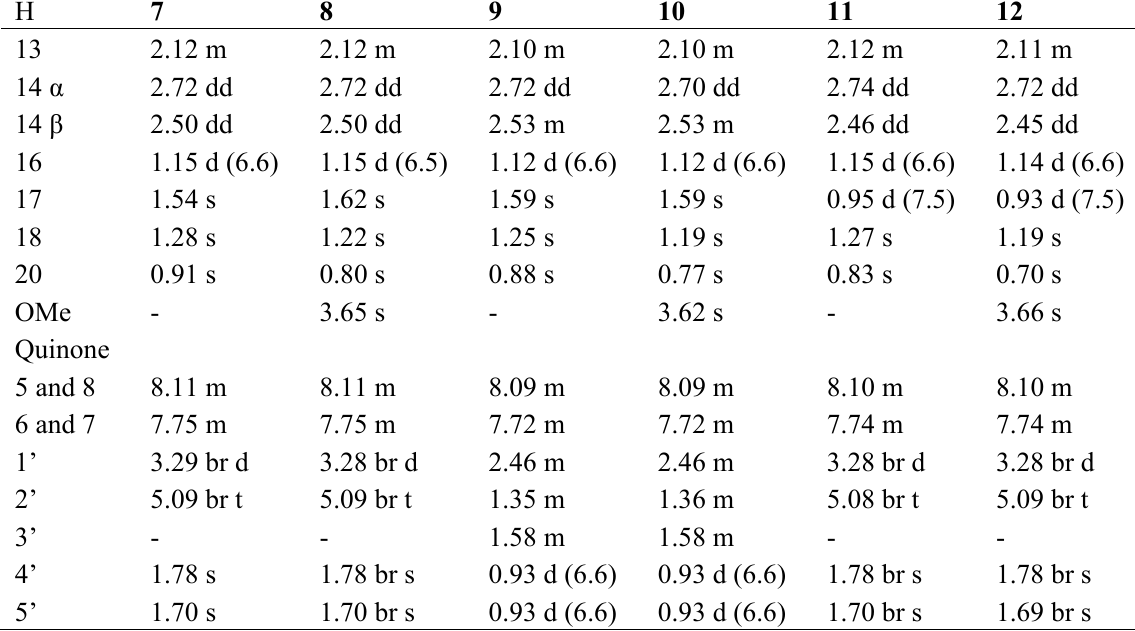
Table 4. Selected 1 H-NMR Data of compounds 7–12